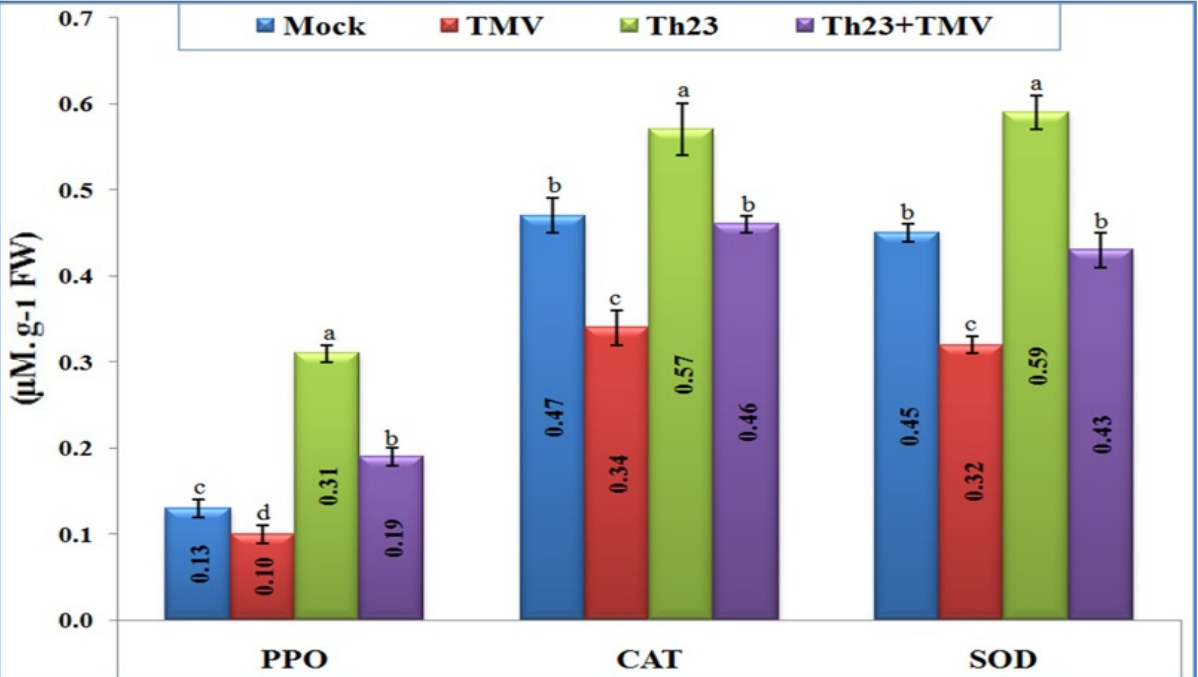
Figure 4. Polyphenol oxidase (PPO), catalase (CAT), and sodium dismutase (SOD) kinetic levels as affected by various treatments including untreated plants (mock), TMV-treated plants (TMV), Trichoderma hamatum strain Th23 application (Th23), and T. hamatum strain Th23 application 48 h before TMV inoculation (Th23 + TMV). The mean values in each of the columns that begin with the same letter are not statistically different ( p ≤ 0.05).